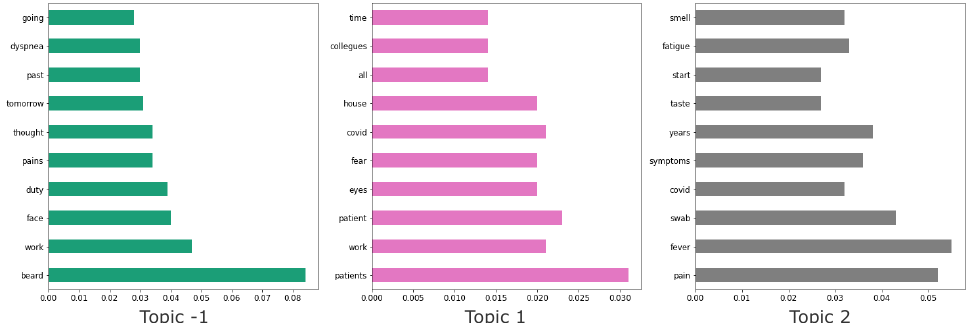
Figure 6. Bar plot of keywords and weight for each topic modeled through the BERTopic approach. Topic -1 represents a virtual topic of unassigned documents to other